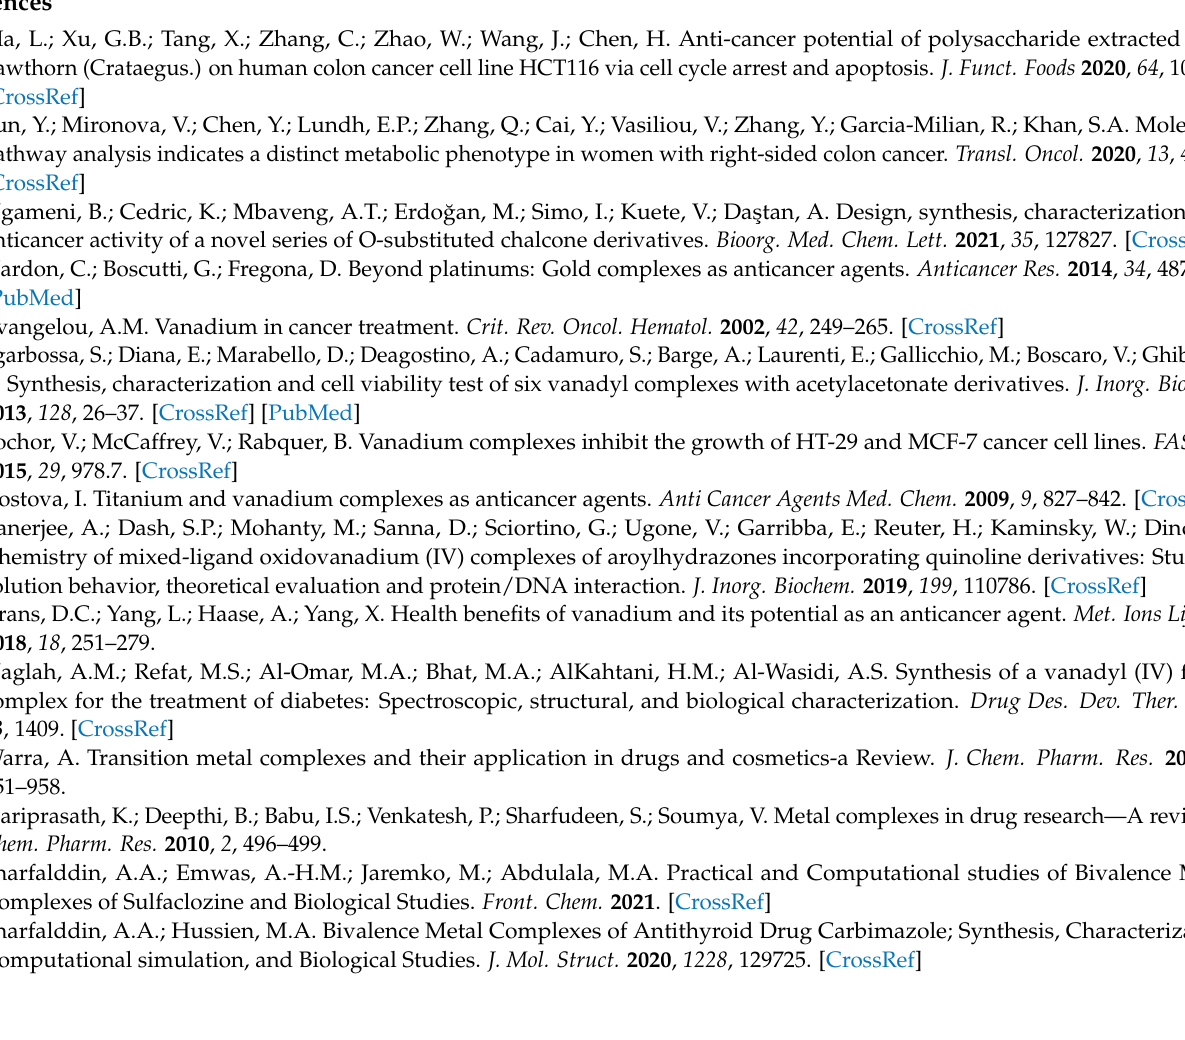
Figure S7: The optimized geometry of the free ligands gas phase using DFT method LANL2DZ basis sets, Figure S8: Absorption spectra of free ligands and their complex in the presence of increasing DNA